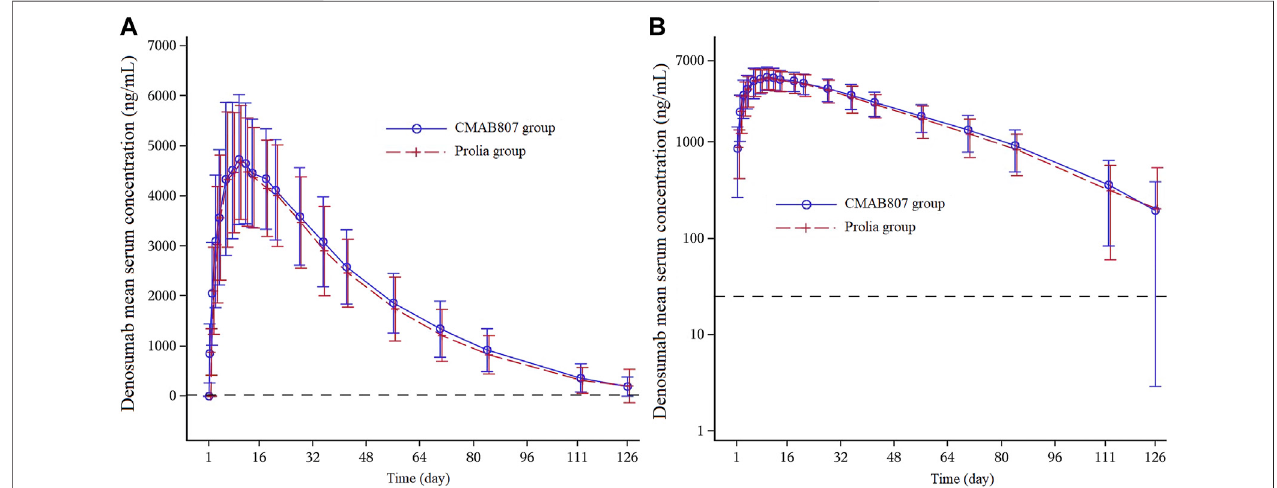
FIGURE 2 | Mean serum concentration-time pro fi les following the SC injection of 60 mg of CMAB807 or denosumab in healthy Chinese male subjects (A) : Linear scale (B) : semilog scale. Note: the error bars indicate the standard deviations (SD); the dashed horizontal line refers to the LLOQ (25.0 ng/ml).